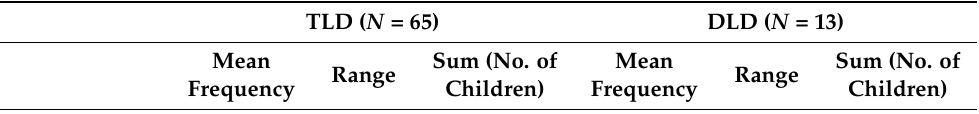
Table 4. Means, ranges, and frequencies of non-targeted CS for three grammatical constituents in English and Hebrew, for children with TLD and DLD.